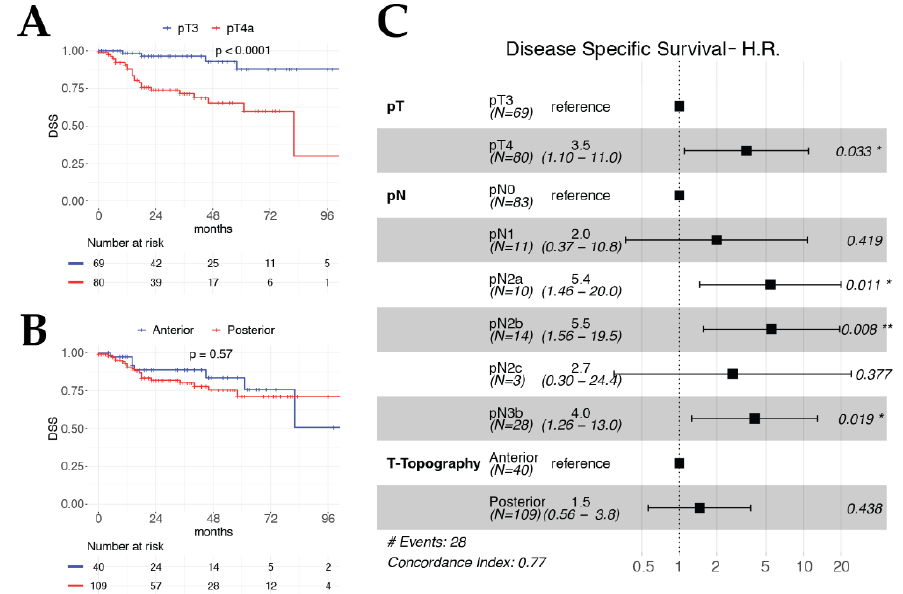
Figure 2. Kaplan–Meier curves for DSS according to pT category ( A ) and T-topography ( B ). Forest plot of DSS multivariable model ( C ).